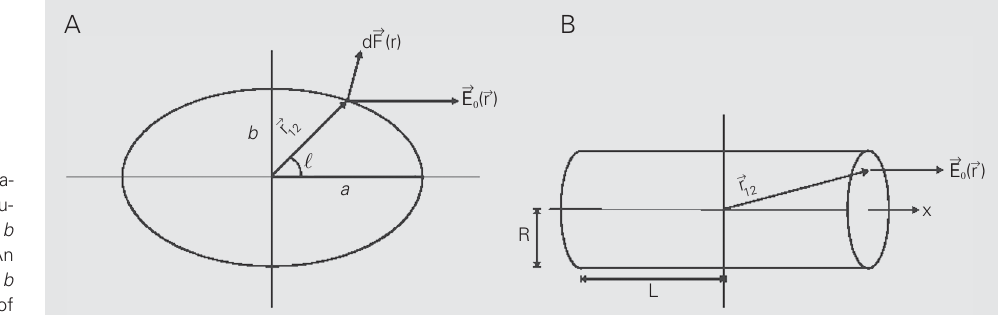
Figure 1. A , Approximate shape of a human erythrocyte with di- ameter 2R and thickness d at the outer rim of 2.2 µm. Neither a prolate ellipsoid (spheroidal cell model of rotational symmetry) nor a spherical single-shell mo- del approaches the shape of the cell very well. B , Rouleaux for- mation of erythrocytes adhering side-by-side forming a cylindrical body of variable length. While the diameter 2R corresponds to that of the single erythrocyte, ( 2R = 7.5 µm ), the rouleaux length (cid:65) is proportional to the stack number s of adhered red blood cells, 2L x s . For s ≥ 4 , a short cylinder with cylinder sym- metry axis of length (cid:65) > 2R is formed.